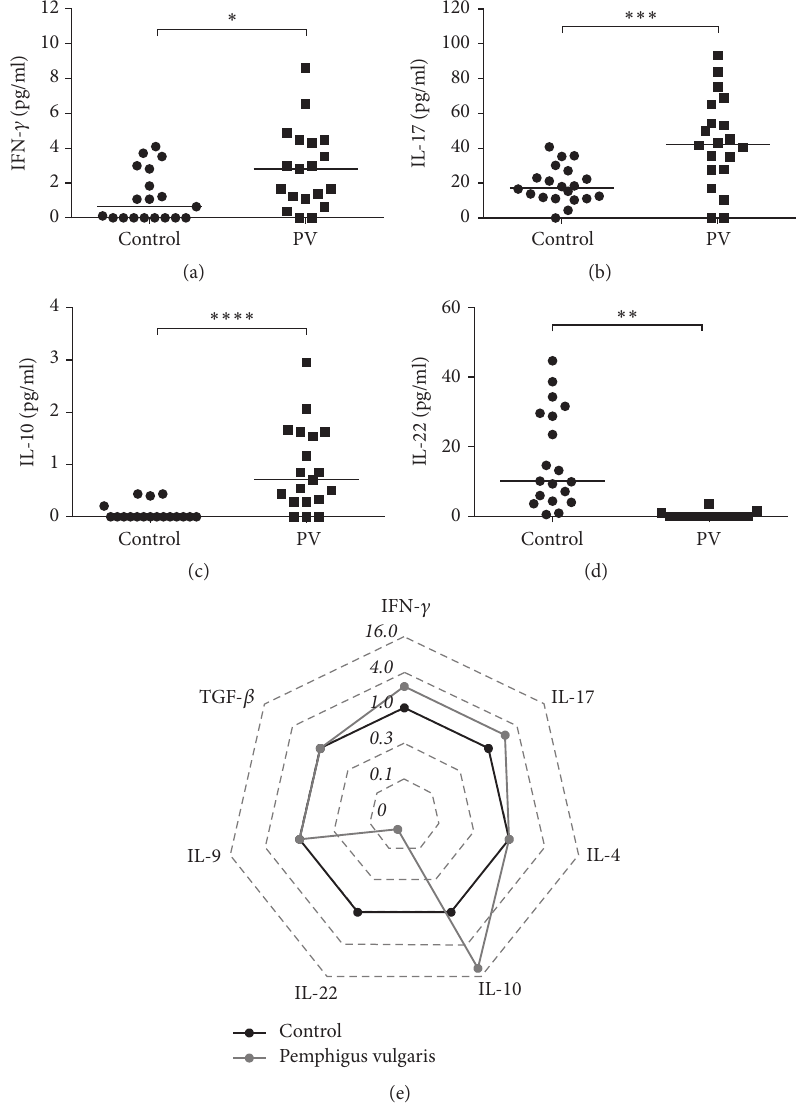
Figure 1: Serum profile of T cell-derived cytokines in Pemphigus vulgaris. Levels of (a) IFN- 𝛾 , (b) IL-17, (c) IL-10, and (d) IL-22 in Healthy Donors ( (cid:2) ) and Pemphigus vulgaris patients ( ◼ ). Error bars represent median ± SD. ∗ 𝑝 < 0.05 ; ∗∗ 𝑝 < 0.01 ; ∗∗∗ 𝑝 < 0.001 ; ∗∗∗∗ 𝑝 < 0.0001 ; Mann–Whitney test. (e) Radar plot representation of serum T cell-derived cytokine profile. The lines highlight the fold change in cytokine levelsinPemphigusvulgarispatients(grayline)inrelationtoHealthyDonors(blackline).Datawereobtainedbycalculatingtheratiobetween the median concentration of each cytokine in the Pemphigus vulgaris group and in the healthy